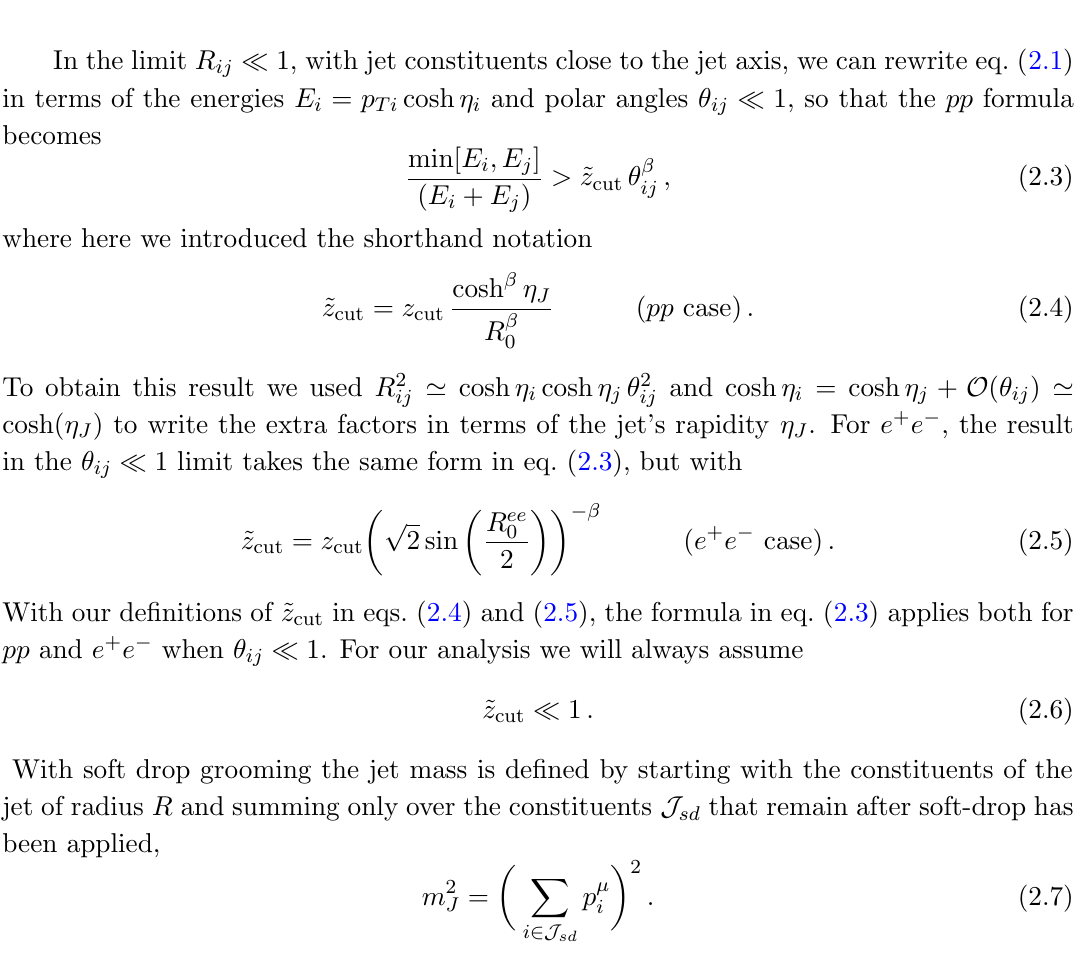
Figure 2 . Pythia prediction for m 2 trum. Here we take R ee region is replaced by a factor of